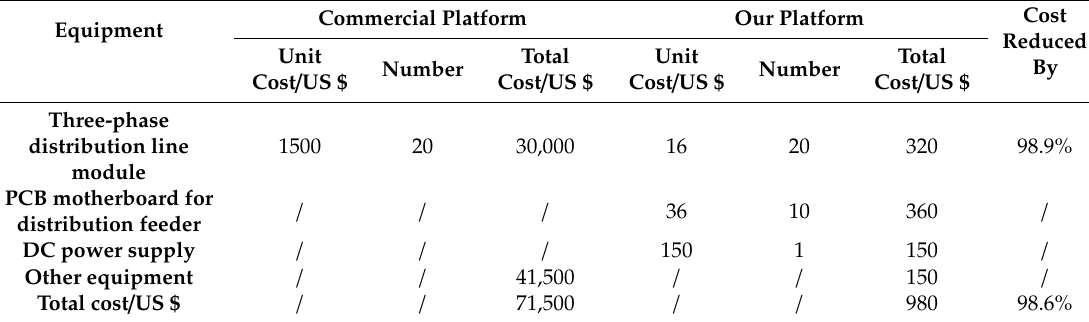
Table 2. Cost comparison between our platform and the commercial